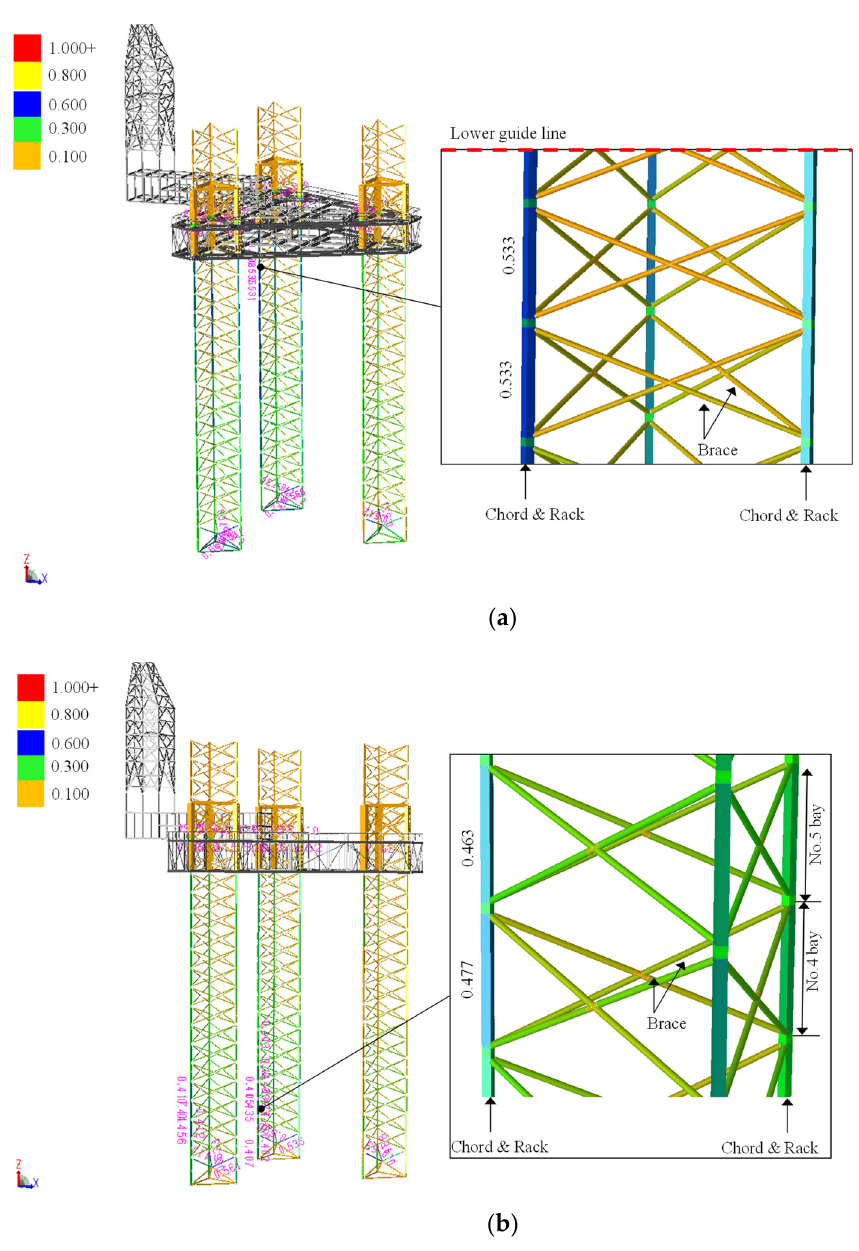
Figure 8. Unit check result according to boundary condition: ( a ) maximum unity check value and location under pinned condition; ( b ) maximum unity check value and location under soil condition.